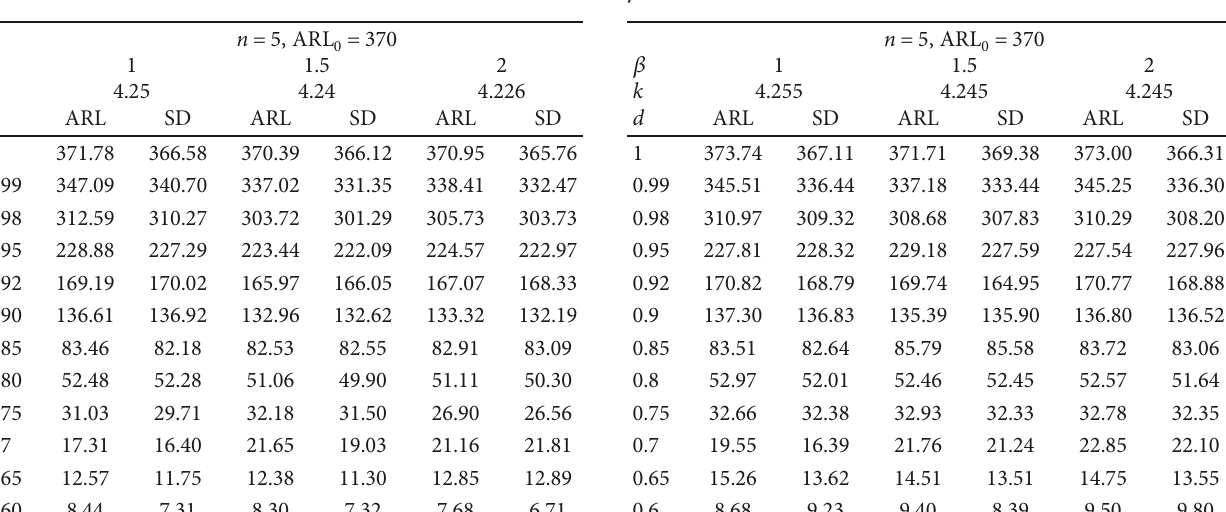
Table 2: The values of ARLs when q = 0 95 , α = 1 10 , θ = 50 , and β = 1 0,1 5,2 0 .